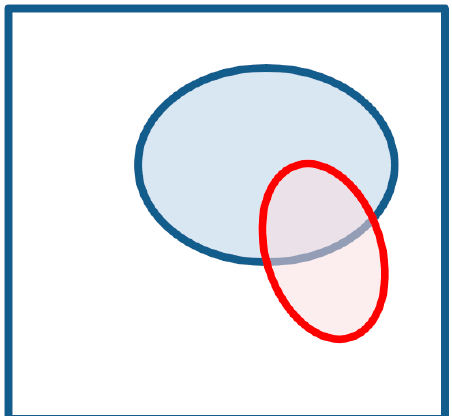
Figure 2. Illustration of joint probabilities as the basis of Bayes’ Theorem. The white box contains all models in the ensemble. Models within the blue ellipse forecast unacceptable damage due to pumping. Models in the red ellipse are deemed more-similar to the stakeholder’s basin.